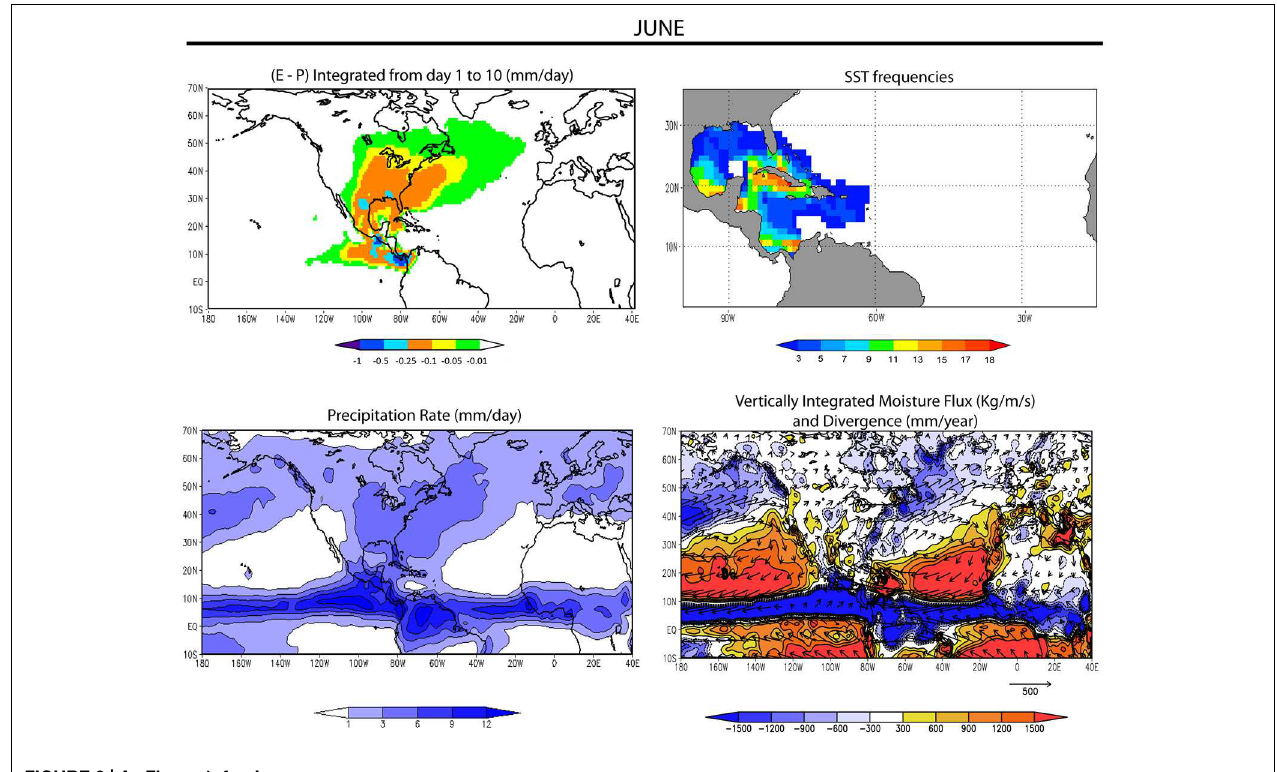
FIGURE 2 | As Figure 1, for June.